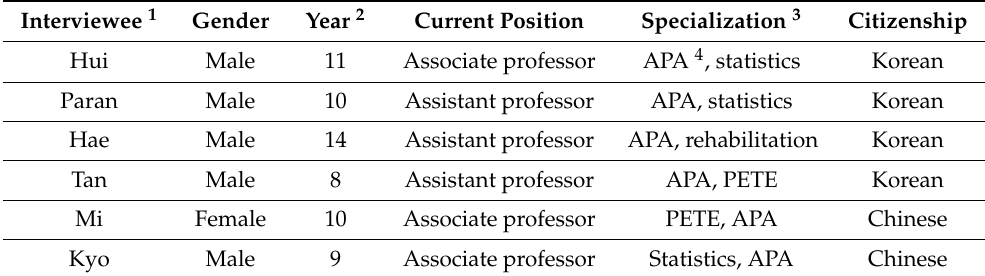
Table 1. Participants